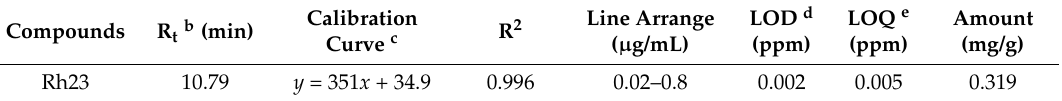
Table 2. Linear regression data and contents of the validated method for the ginsenoside Rh23 in HPGL extract a . Calibration Compounds R t b (min) Curve c